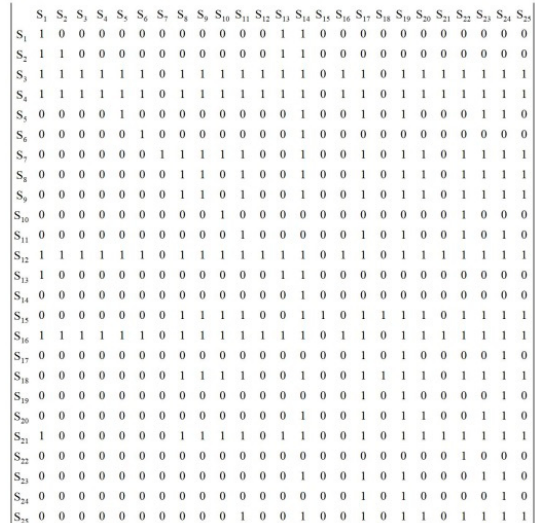
Figure 2. Adjacency matrix A.